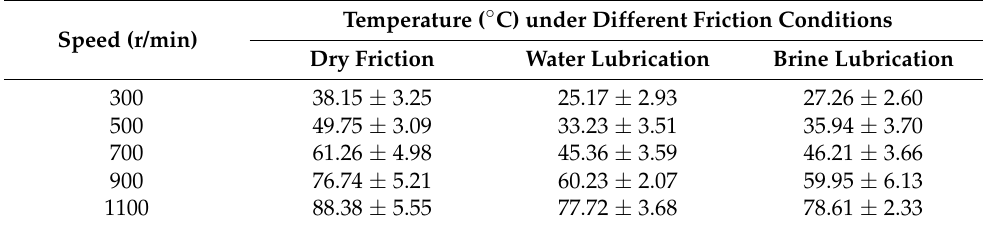
Table 4. Temperatures of UHMWPE surface at 50 N load under different friction conditions.